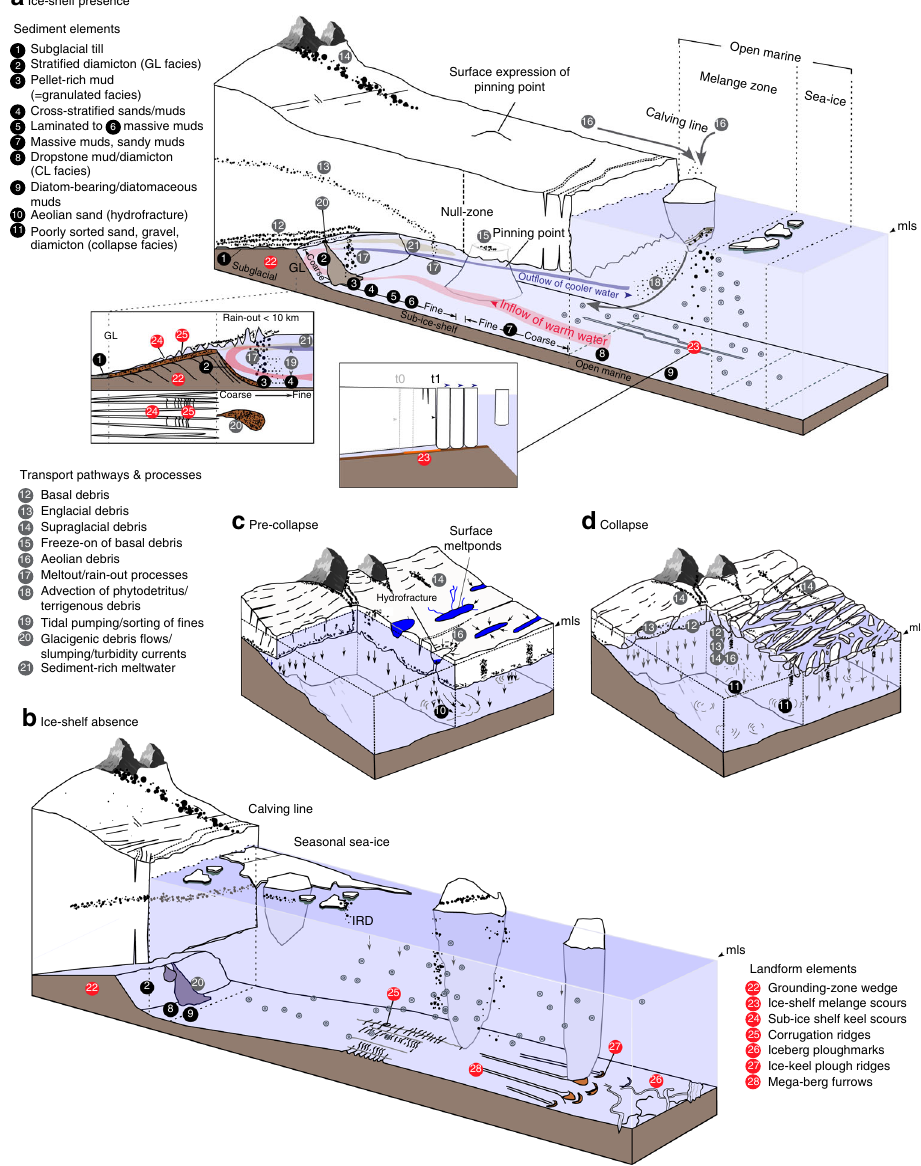
Fig. 5 Conceptual model of the sediments and landforms associated with a ice shelf presence, b absence, c pre-collapse and d collapse (panel c , d modi fi ed from ref. 94 ). The characteristics of each sediment element is summarised in Fig. 4. Landform elements are summarised in Table 1. msl mean sea